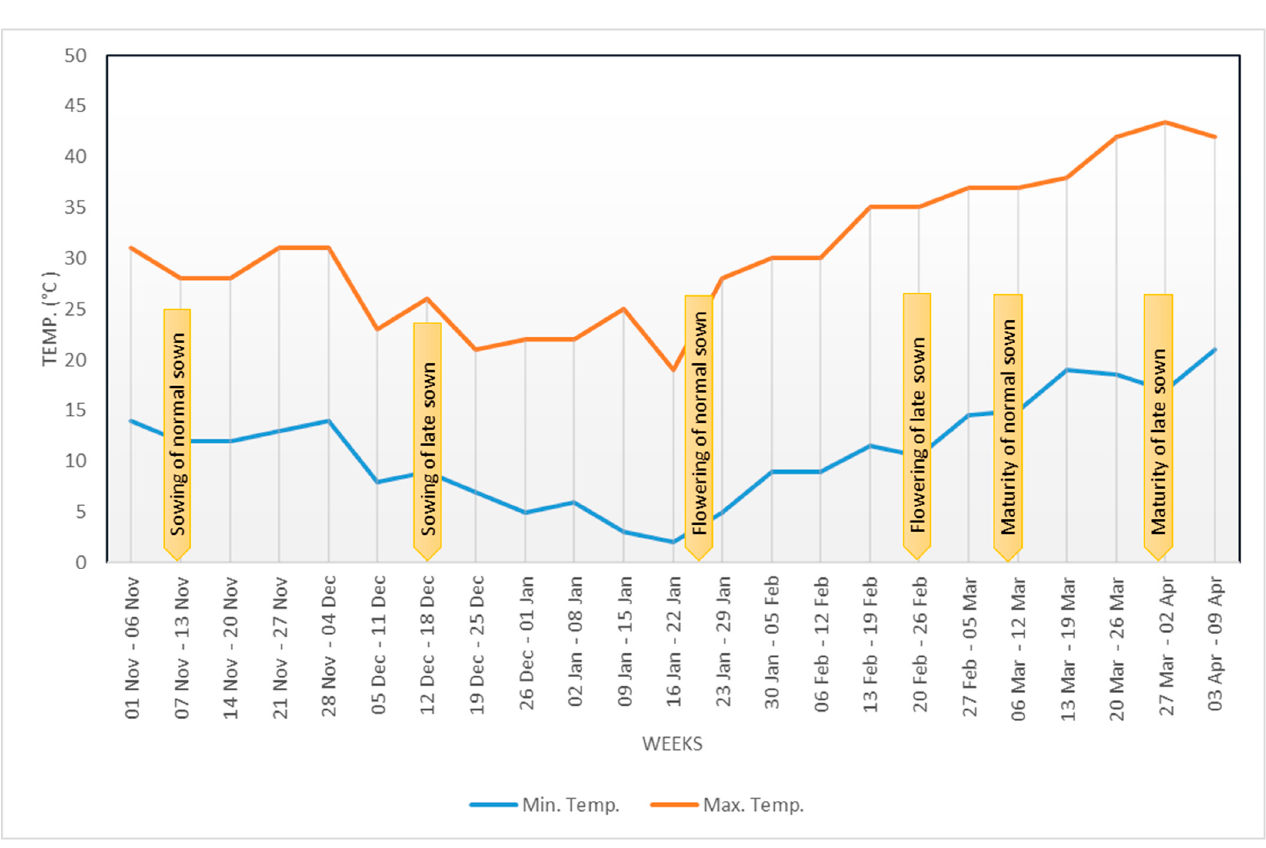
Figure 16. Weekly temperature data recorded during cropping period at the experimental